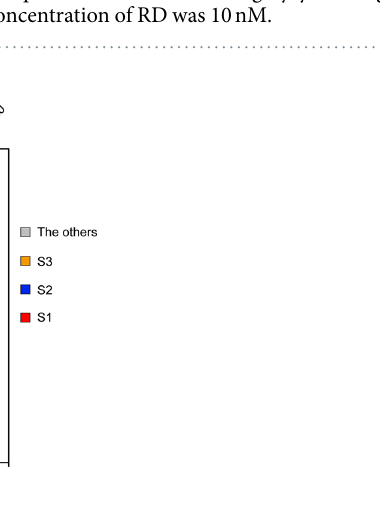
Figure 4. The fraction of S1, S2, and S3 in the sequencing reads from 0–8R RNA pools from SELEX. Total counts are the numbers of total reads obtained by HTS. S1, S2, S3, and others are shown in red, blue, orange, and gray bars,